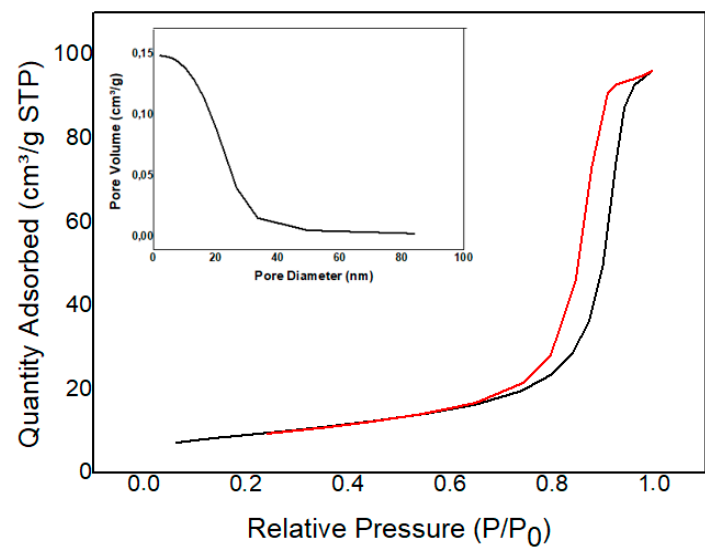
Figure 3. N 2 adsorption / desorption of NiFe 2 O 4 .